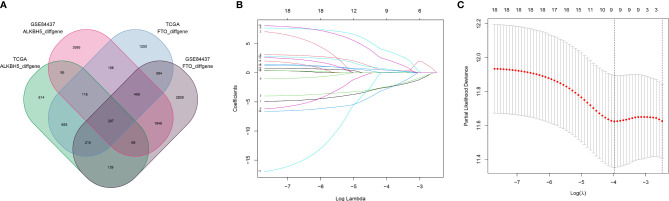
Screening of 9 m6A “eraser” related risk genes. (A) Venn diagram showing 297 commonly and differentially expressed genes in four groups with different data. (B, C) LASSO regression was employed to calculate the minimum criteria (B) and coefficients (C).